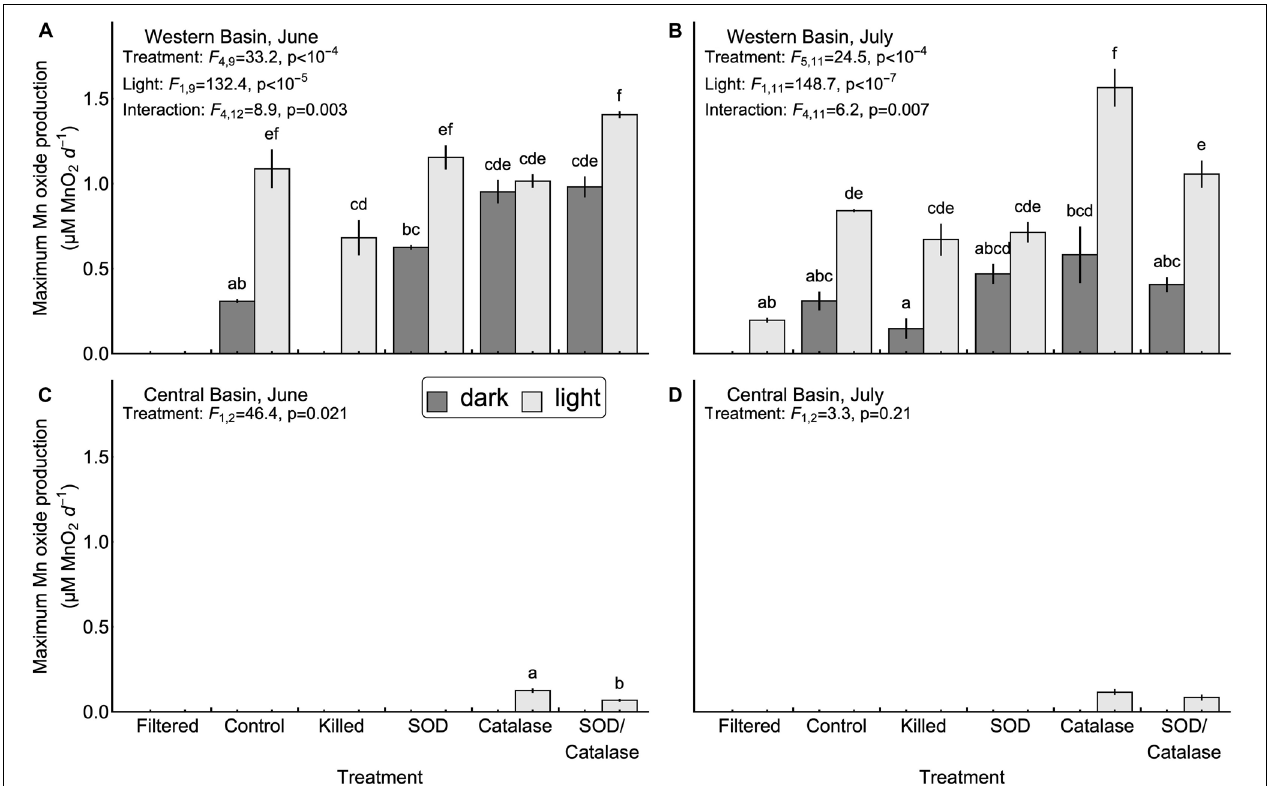
FIGURE 3 | Maximum Mn oxide production rates observed in the western (A,B) and central basins (C,D) . Error bars represent the values measures in two experimental replicates. No bars were drawn for treatments where significant Mn oxide production was not observed over the course of the experiment, or for the July experiment in the central basin due to a lack of significant differences among treatments. Inset letters denote groups of treatments that were not significantly different based on post-hoc comparisons ( p < 0.05). Any two treatments that do not share one letter in common are interpreted as different by this criterion.